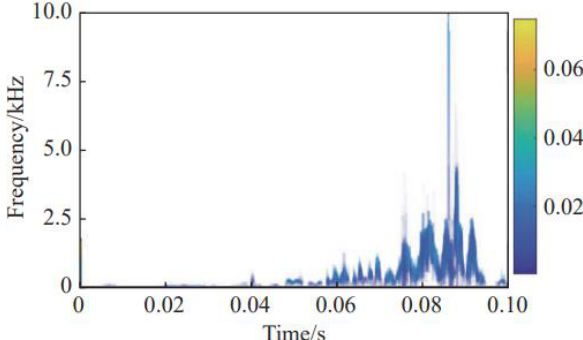
Figure 10. Hilbert spectrum of interference signal.